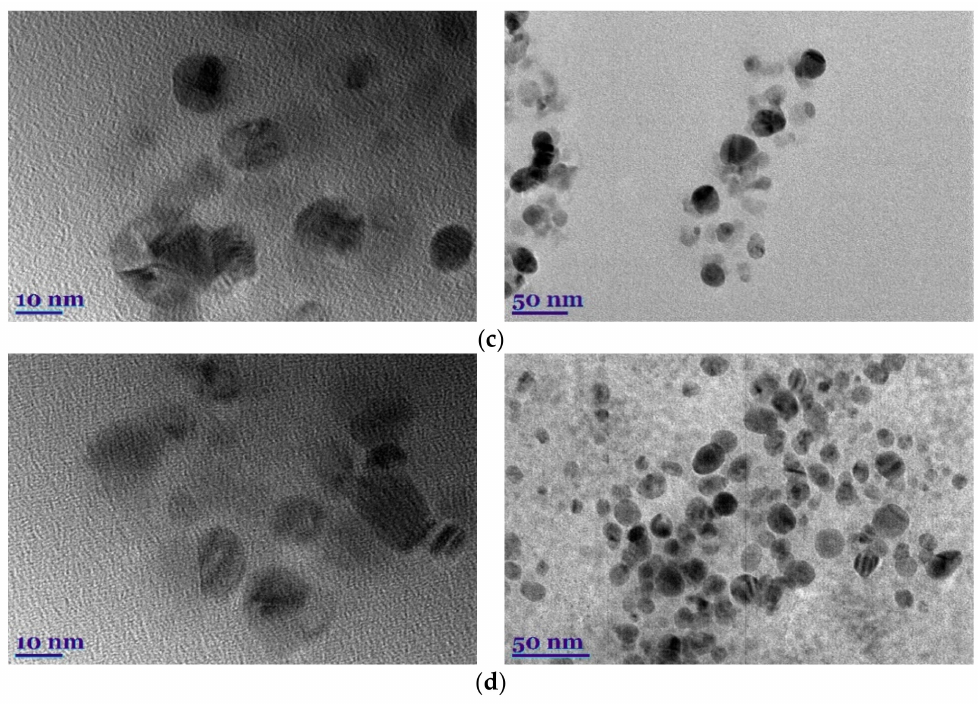
Figure 2. TEM micrographs of AgNPs using C. islandica ( a ), F. esculentum ( c ), and enzyme-assisted C. islandica ( b ) and F. esculentum ( d )